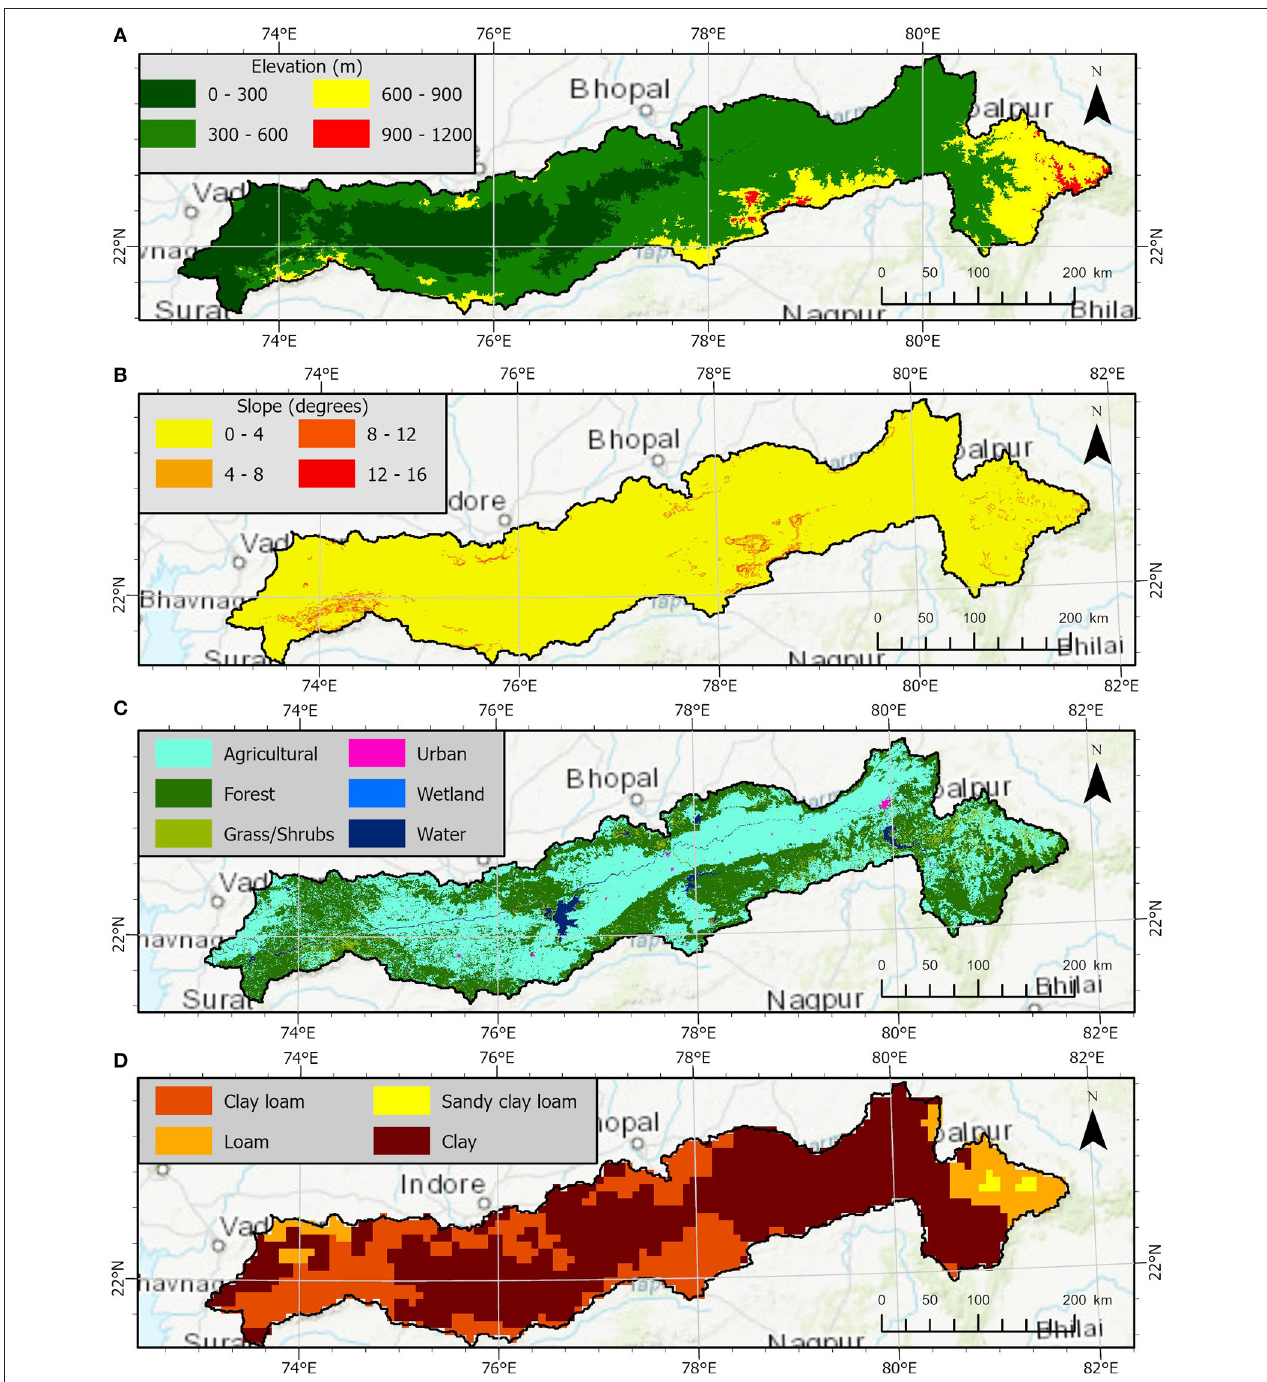
FIGURE 2 | (A–D) : (A) Digital Elevation Model (DEM) map; (B) Slope map; (C) Land cover map. (D) Soil map used as topographical and spatial input forcing for setting up the SWAT model.